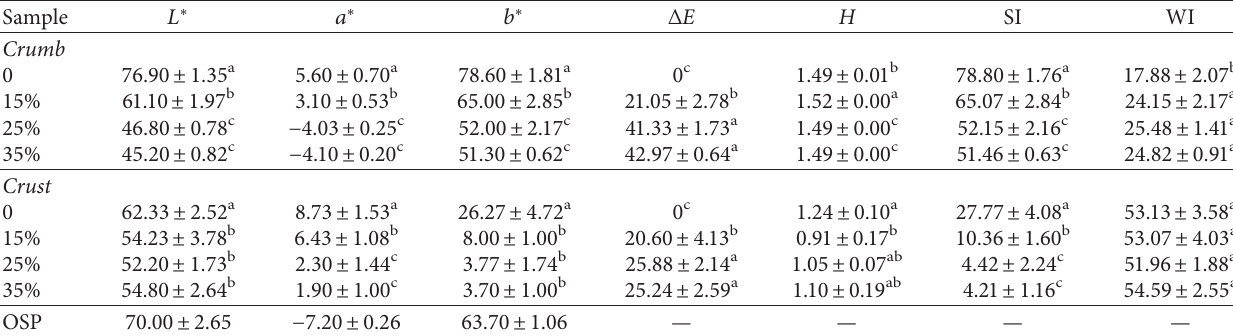
Table 4: Color parameters of OSP and sponge cake prepared with different levels of OSP † . Sample